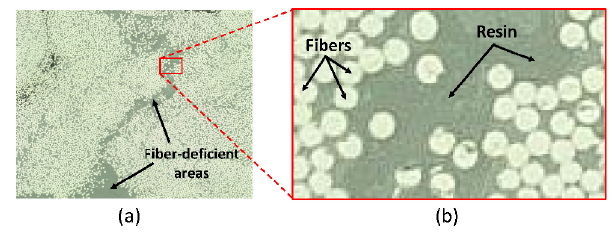
Fig. 1 (a) Transverse optical microscope image, and (b) a close-up, showing a cross-section of fibers and resin.